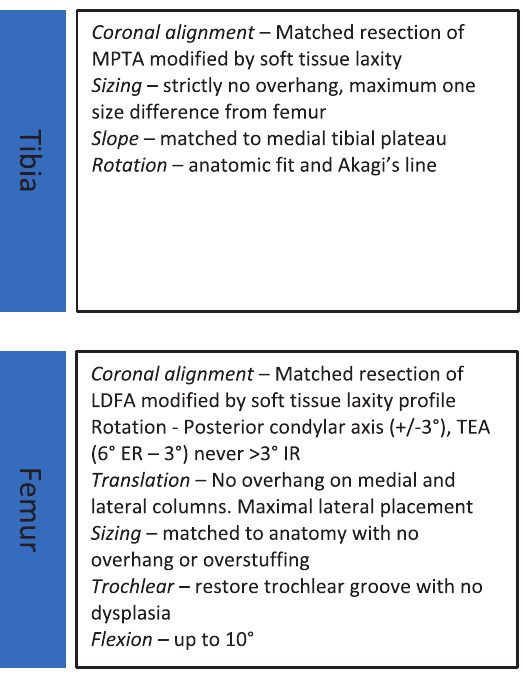
Figure 2. Functional Alignment